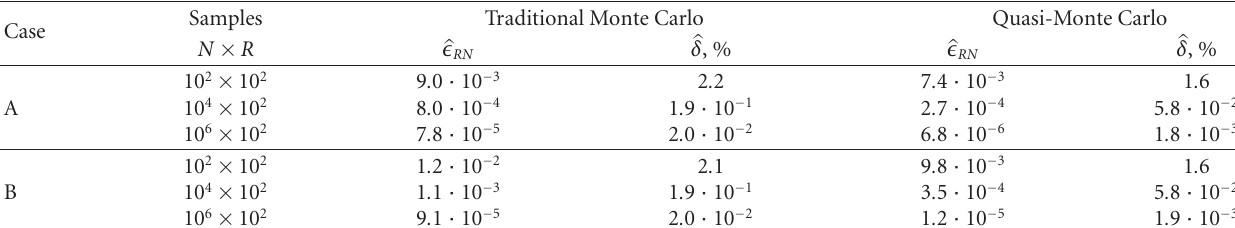
Table 5: Maximal error of Monte Carlo quadratures.